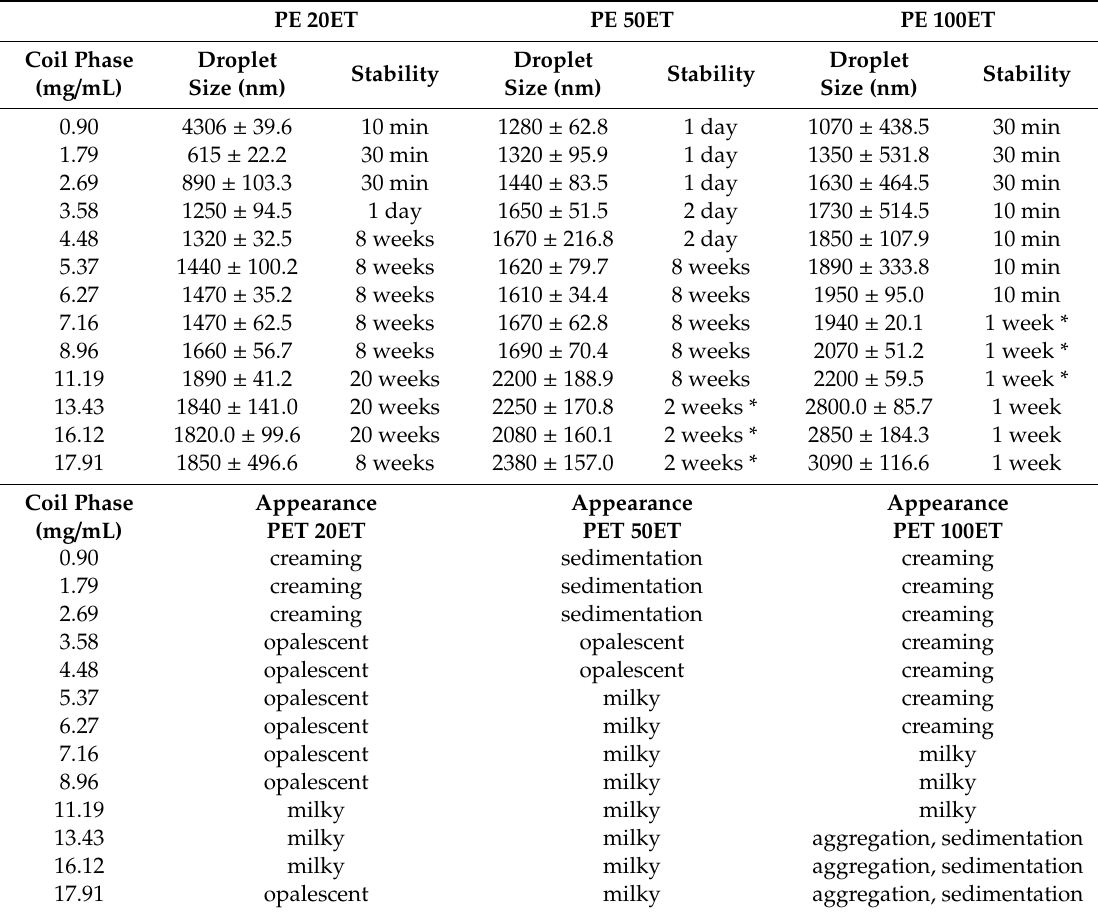
Table 3. Parameters of Pickering emulsions of Melaleuca alternifolia EO and tioconazole stabilized with 20ET, 50ET, and 100ET SNPs. * These emulsions were creaming, but after 30 s shaking, their droplet size recovered to the original value, and they retained again their stability for 1